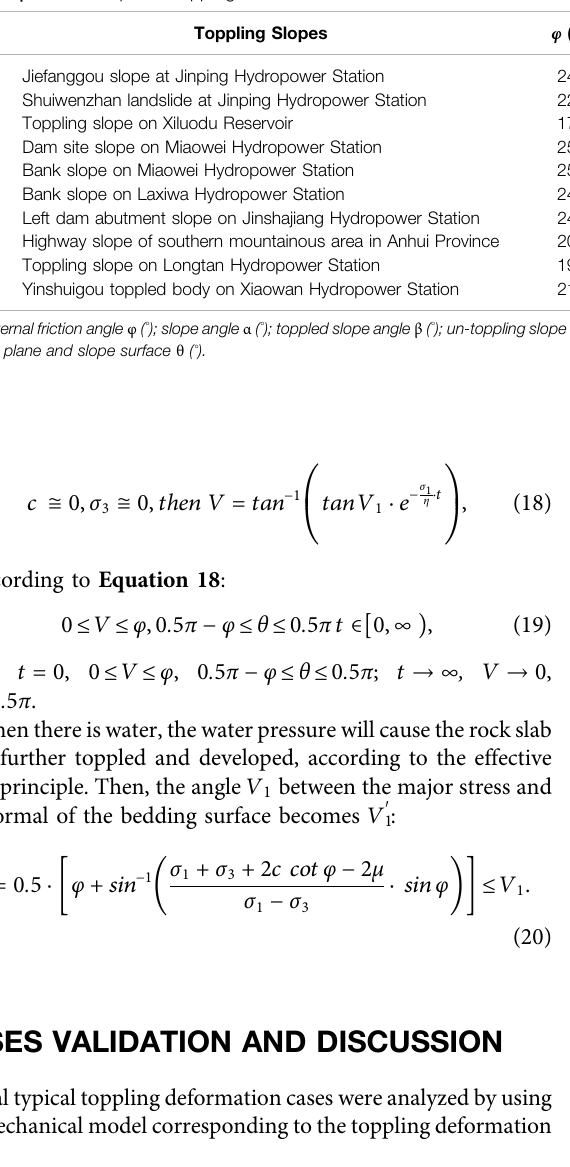
TABLE 1 | Some examples of toppling deformation and